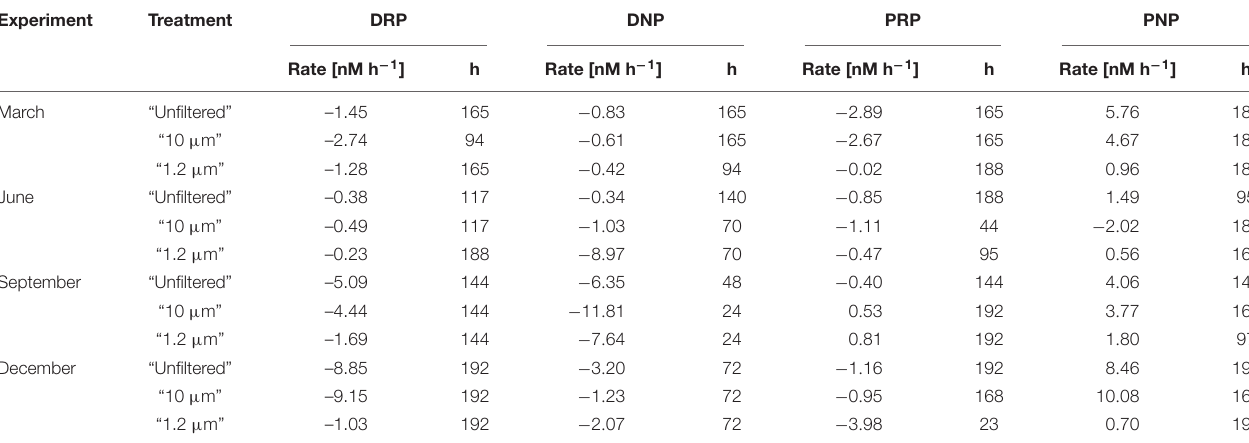
TABLE 7 | Degradation rate of the phosphorus (P) fractions in experiments based on respective median values.